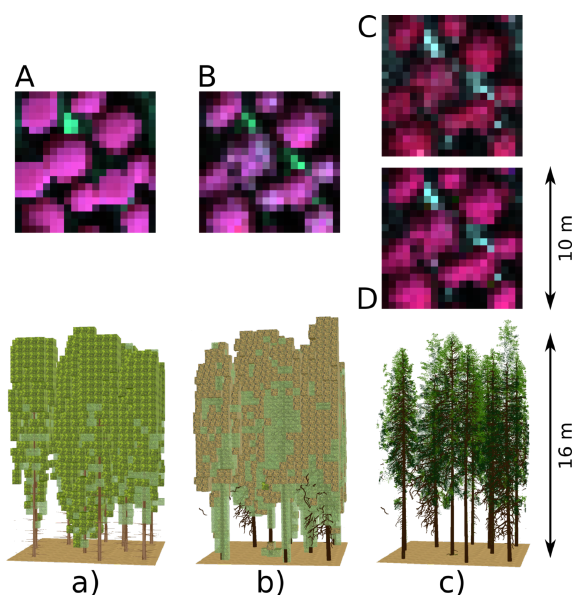
Figure 7. Visualization of Norway spruce forest 3D scenes ( a – c ) and DART-simulated top-of-canopy reflectance images for scenarios A – D . ( a ) scenario A , basic turbid , with DART predefined crown shapes and foliage as turbid cells (solid green voxels represent foliage with predefined optical properties, whereas semi-transparent light green voxels are foliage intersected by 3D woody objects), ( b ) scenario B , needle turbid , with 3D trees reconstructed from TLS data occupied by turbid cells converted from facet-based needle shoots (solid brown voxels represent foliage with mixed optical properties of current-year and older-needle shoots), and ( c ) scenario C , plane facet , and scenario D , needle facet , with 3D trees reconstructed from TLS data having shoots approximated as planes or retained as needle facets. The upper images ( A – D ) show nadir false colour composites (red = 779 nm, green = 666 nm, and blue = 552 nm) of simulated forest canopy reflectance for each